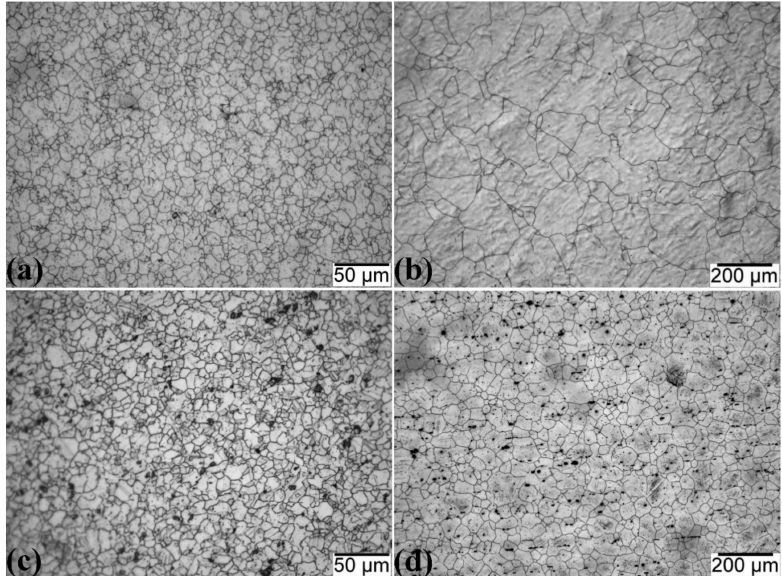
Figure 3. Optical micrographs from: ( a ) F138 as-received; ( b ) F138 after reheating at 1200 ◦ C; ( c ) ISO as-received and ( d ) ISO after reheating at 1200 ◦ C. Black spots in ( c ) and ( d ) correspond to large second phase particles [16].